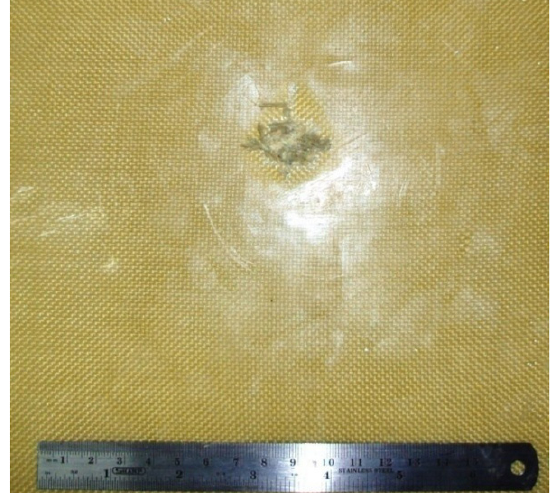
Figure 8. Damage on rear face of 30/60/30/60 19 layer laminate.